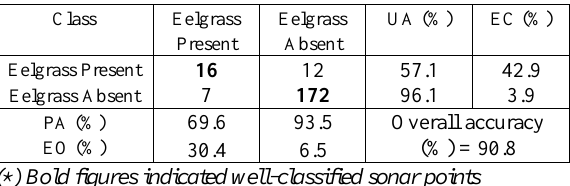
Table 10. Confusion matrix (in sites) and associated accuracies when the UAV Micasense RF classified image is compared to the sonar